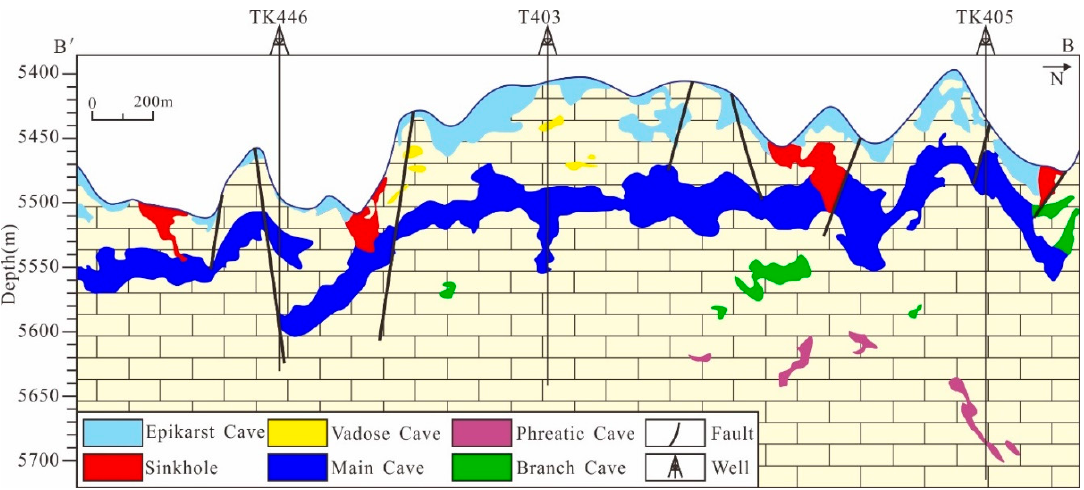
Figure 8. Geologic section crossing wells TK405 ‐ T403 ‐ TK446 regarding the structure of paleokarst reservoirs in the Tahe oilfield. Note: The amplitude seismic and acoustic impedance inversion profiles are shown in Figure 6; see the profile location B ‐ B’ in Figure 1d and Figure 7b.